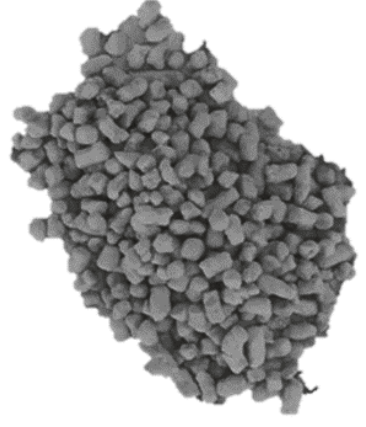
Figure 12: Cylindrical shape.